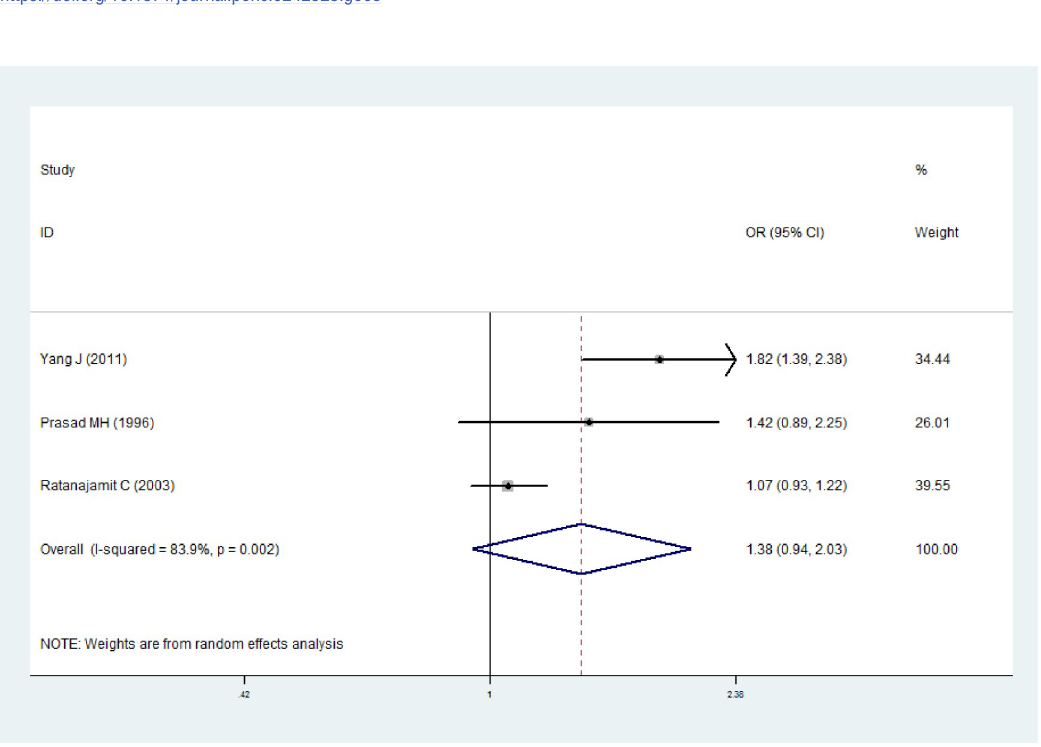
Fig 6. Forest plot with pooled odds ratios of the effect of maternal exposure to sulfonamides on preterm birth/low birth weight.